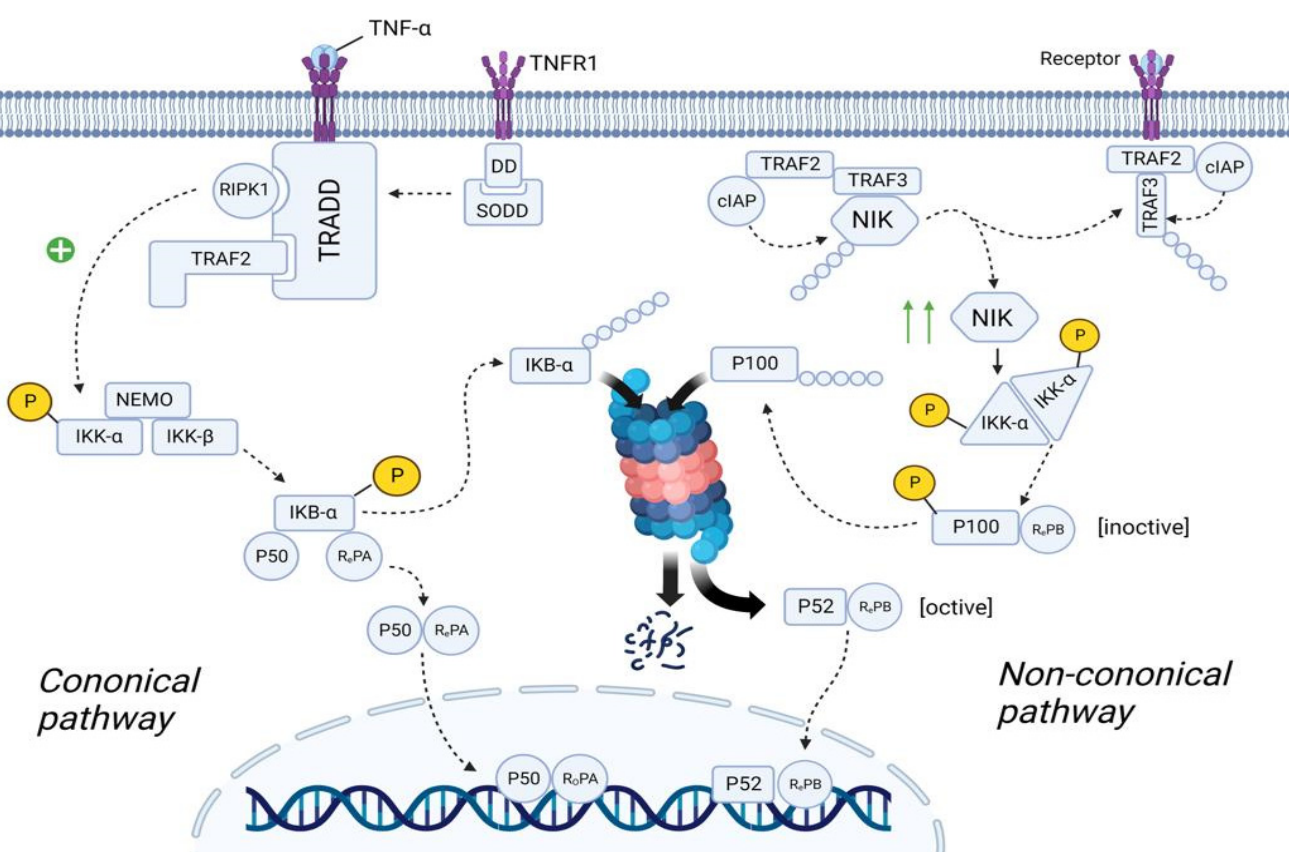
Figure 8. The role of the NF- κ B in the SFP mechanism. Canonical pathway: TNF- α binds to TNFR1 and TNFR1 undergoes homotrimerization. Then, SODD dissociates from the TNFR1, which will lead to the recruitment of TRADD. In turn, TRADD recruits RIPK1 and IKK. RIPK1 phosphorylates and activates IKK. IKK starts phosphorylating the IkB α subunit of the NF-k β and thereby promotes ubiquitination and further proteosomal degradation of IkB α . As a result, NF-k β is trans- ported to the nucleus. Non-canonical pathway: In the resting state, TRAF2/TRAF3/cIAP/NIK complex exists. Formation of this complex will lead to the proteosomal degradation of NIK. After proteosomal degradation. The number of NIK in the cell increases. NIK starts phosphorylating